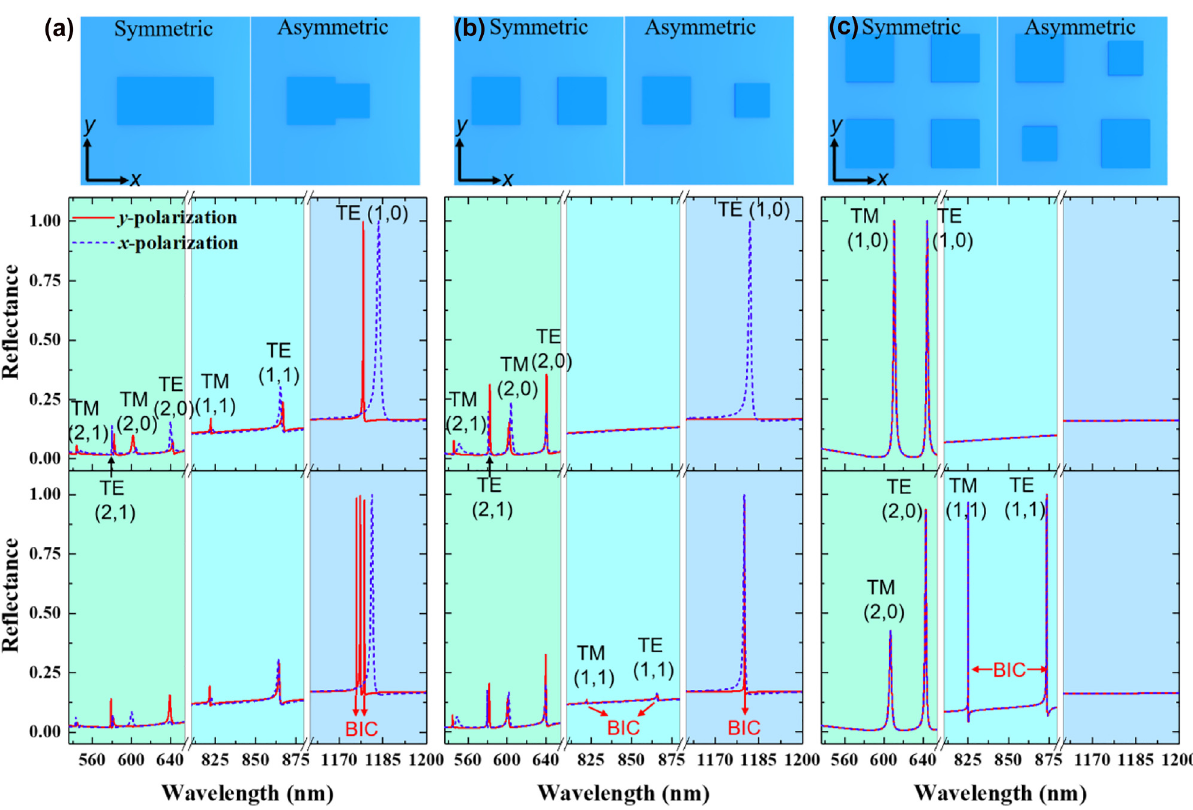
Figure 2: Optical properties of (a) monomer, (b) dimmer, and (c) tetramer unit-atom design in air. Top panel: Schematics of the different meta-atom geometries. Middle panel: Reflection spectra for symmetric metasurfaces under different polarization. Bottom panel: Reflection spectra for = w = 280 nm, t = 60 nm, and t = 140 nm. For asymmetric asymmetric metasurfaces under different polarization. For symmetric structures, w 1 2 g w g = 280 nm, w = 200 nm, t = 60 nm, and t = 140 structures, w 1 2 g w g